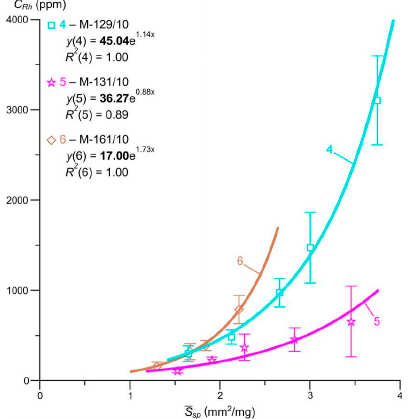
Figure 8. Dependences of the average content of evenly distributed rhodium on the specific surface area of an average crystal in size fractions of arsenopyrite from vein and streaky-vein ores of the Natalkinskoe deposit.